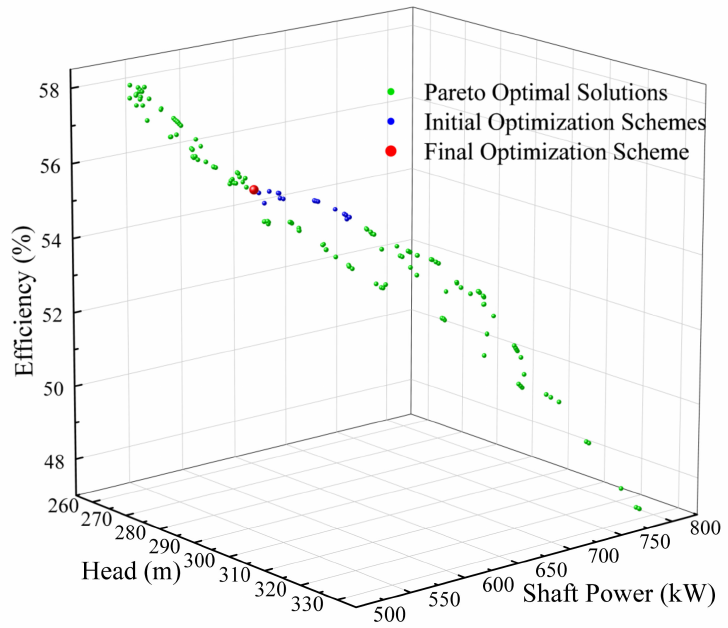
Figure 12. Pareto optimal